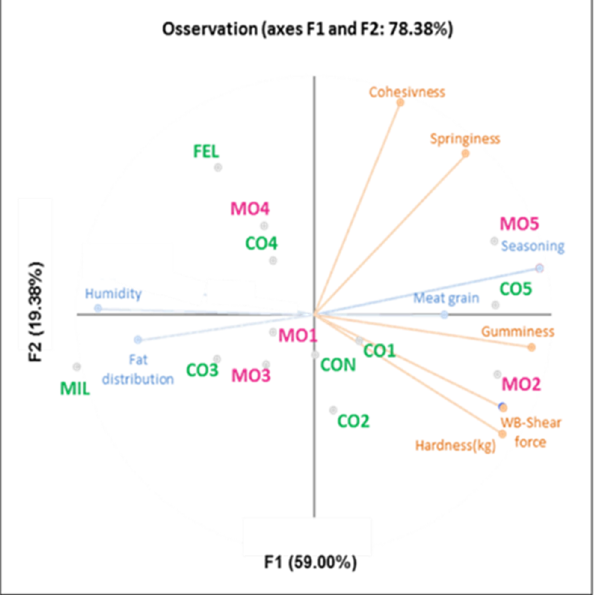
Figure 4. Projection of samples and variables (textural and sensory results) in multifactorial analysis (MFA biplot). Mora Romagnola and conventional pig breed salami samples are labelled in pink and green, respectively. Samples were coded as CO1 (conventional salami with small size), MO1 (Mora Romagnola salami with the same size as CO1), CO2 (conventional salami of “Nostrano” type), MO2 (Mora Romagnola salami similar to CO2), CO3 (conventional salami of “Cacciatore” type), MO3 (Mora Romagnola salami similar to CO3), CO4 (conventional salami obtained directly from a local producer), MO4 (Mora Romagnola salami similar to CO4), CO5 (conventional salami obtained directly from a local producer), MO5 (Mora Romagnola salami similar to CO5), CON (conventional salami of “Contadino” type), FEL (conventional salami of “Felino” (PGI) type), and MIL (conventional salami of “Milano” type).